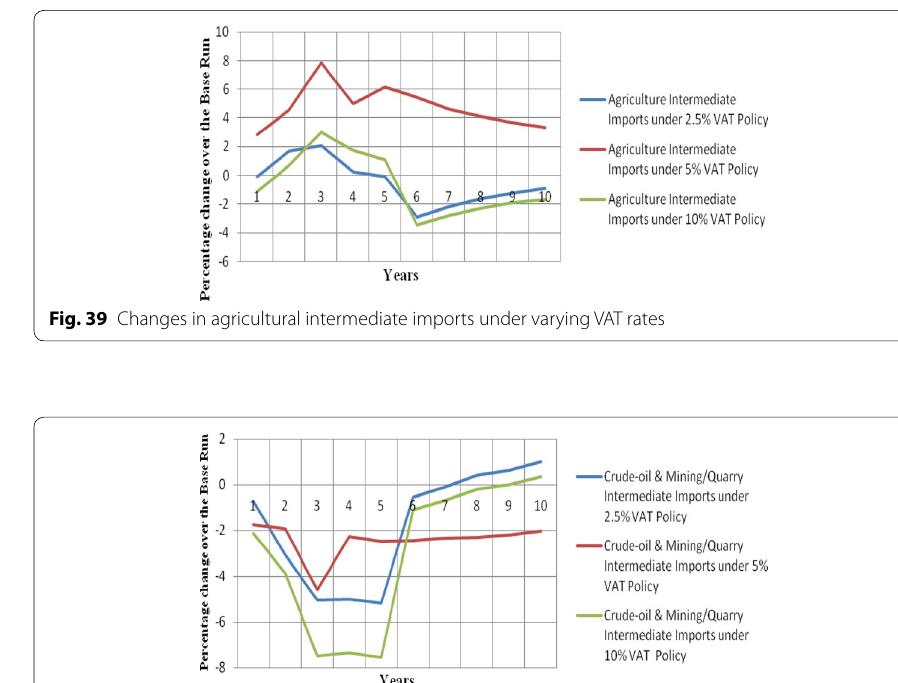
Fig. 40 Changes in crude oil/gas and mining/quarry intermediate imports under varying VAT rates